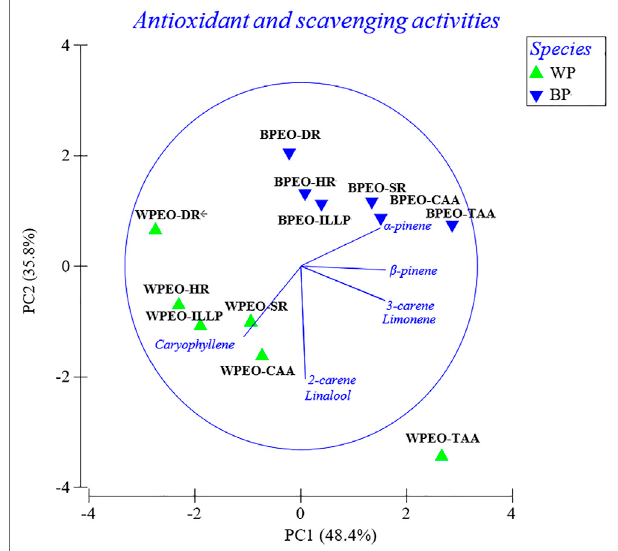
FIGURE 4 | PCA plot showing the grouping of WPEO and BPEO based ontheratioofsevenstandardstoessentialoilsintermsofdifferentantioxidant and scavenging activities (CAA, intracellular antioxidant activity; TAA, total antioxidant activities; SR, superoxide radical scavenging activity; HR, hydroxyl radical scavenging activity; DR, DPPH radical scavenging activity; ILLP, inhibition oflipoprotein lipid peroxidation; WPEO, whitepepper essential oil; BPEO, black pepper essential oil; the symbols in same shapes stand for the same